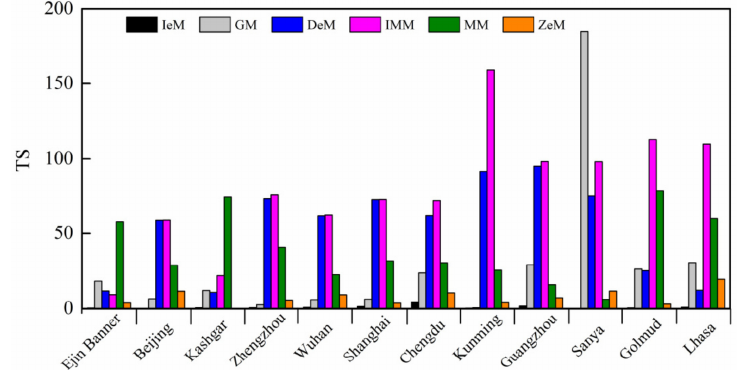
Figure 4. TS values for the six models at 12 selected